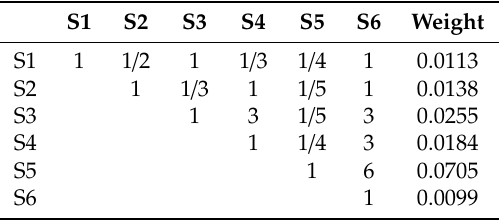
Table A1. Pairwise comparison matrix of Social